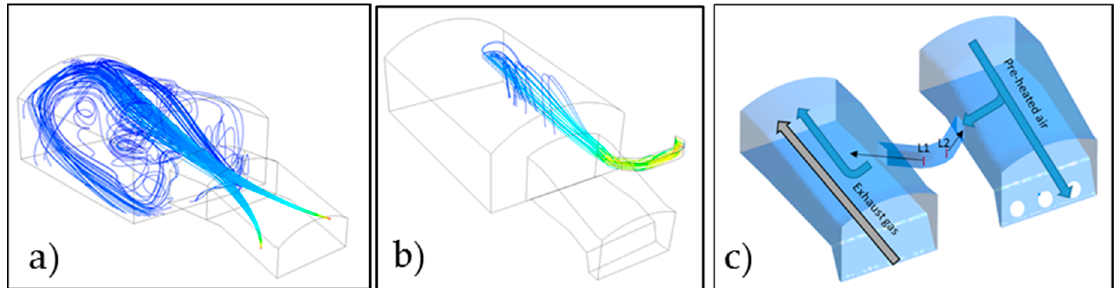
Figure 3. Schematic view of air stage solutions: ( a ) cold, ( b ) hot, ( c ) hybrid.